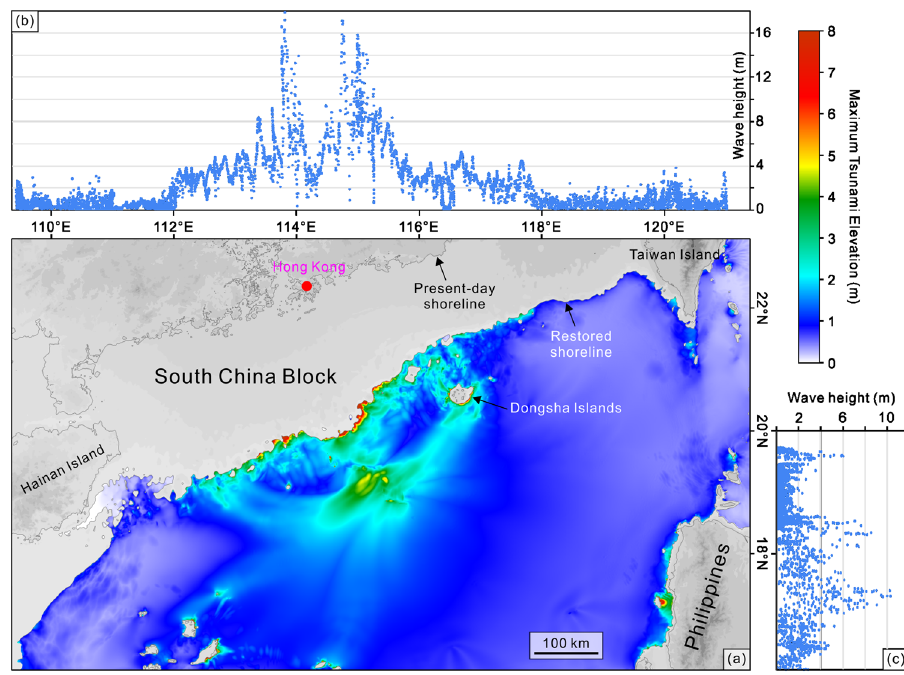
Fig. 8 Maximum tsunami-wave height generated by the 0.54 Ma bathymetric conditions and shoreline position. a Maximum tsunami-wave height generated by a submarine landslide considering the 0.54 Ma bathymetry and shoreline position. b Tsunami-wave height along the shoreline of the northern South China Sea reaches a maximum of ~17 m. c Tsunami-wave height along the shoreline of the eastern South China Sea reaches a maximum of ~10